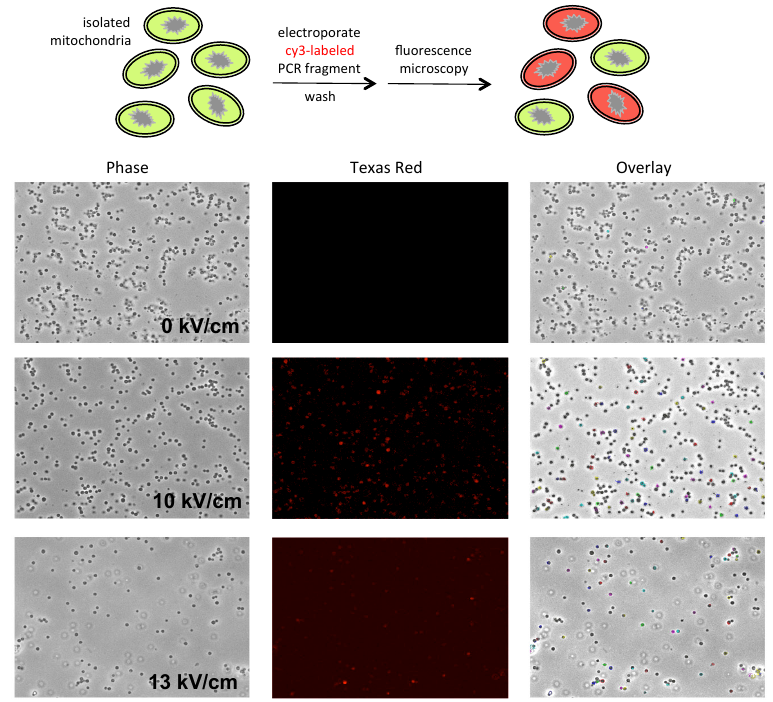
Figure 1. Uptake of cy3-labeled DNA into isolated mitochondria upon electroporation: ( Top ) Schematic representation of the experiment; and ( Bottom ) ( left ) phase contrast images of purified mitochondria incubated with a 847 bp cy3-labeled PCR fragment without (0 kV/cm) or with electroporation at either 10 kV/cm or 13 kV/cm; ( center ) visualization of cy3 fragment uptake via fluorescence microscopy; and ( right ) overlay of the fluorescent signals (shown in color) onto the respective phase